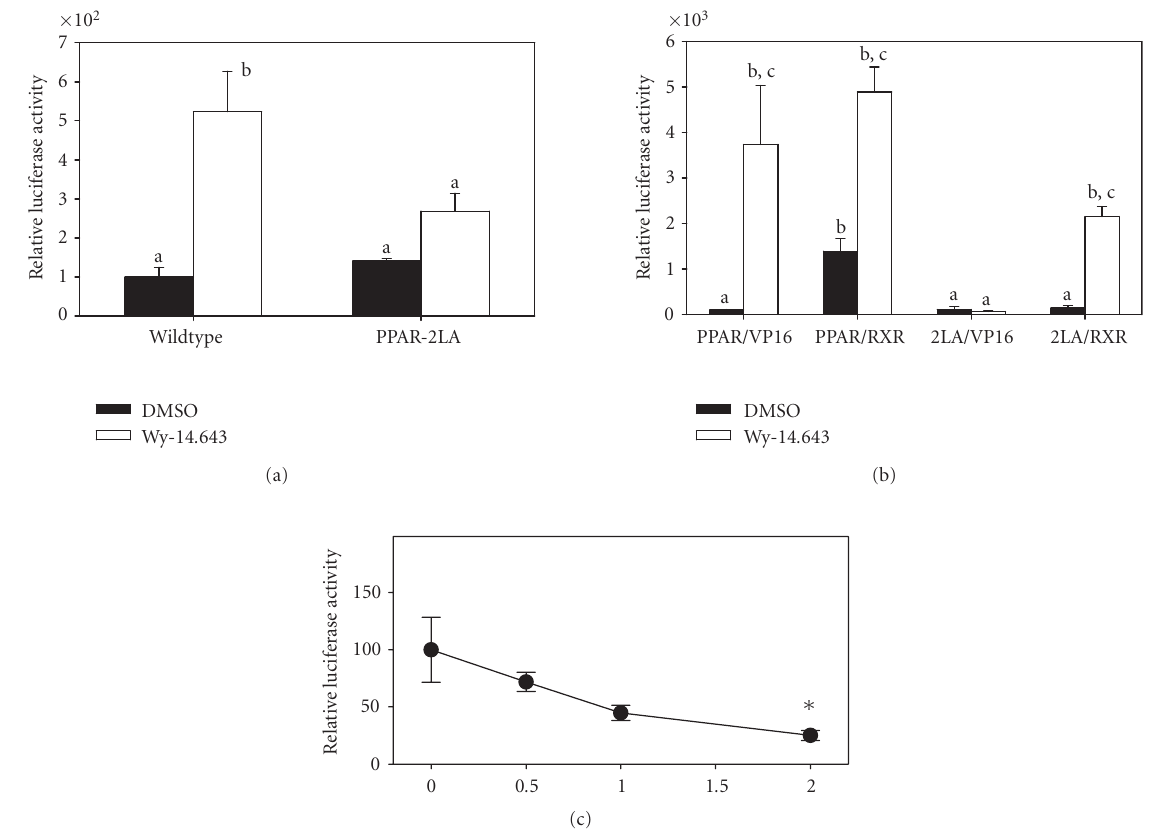
Figure 5: Mutation of 456 LHPLL in PPAR α decreases PP-induced transcriptional activity. Panel (a): 456 LHPLL of rat PPAR α was mutated to 456 LHPAA (mutant designated 2LA) using site-directed mutagenesis. COS-1 cells were transiently transfected with wild type or 2LA mutant PPAR α , a PPRE driven luciferase, and transfection e ffi ciency control. Cells were treated for 6 hours with 50 μ M Wy-14,643 and